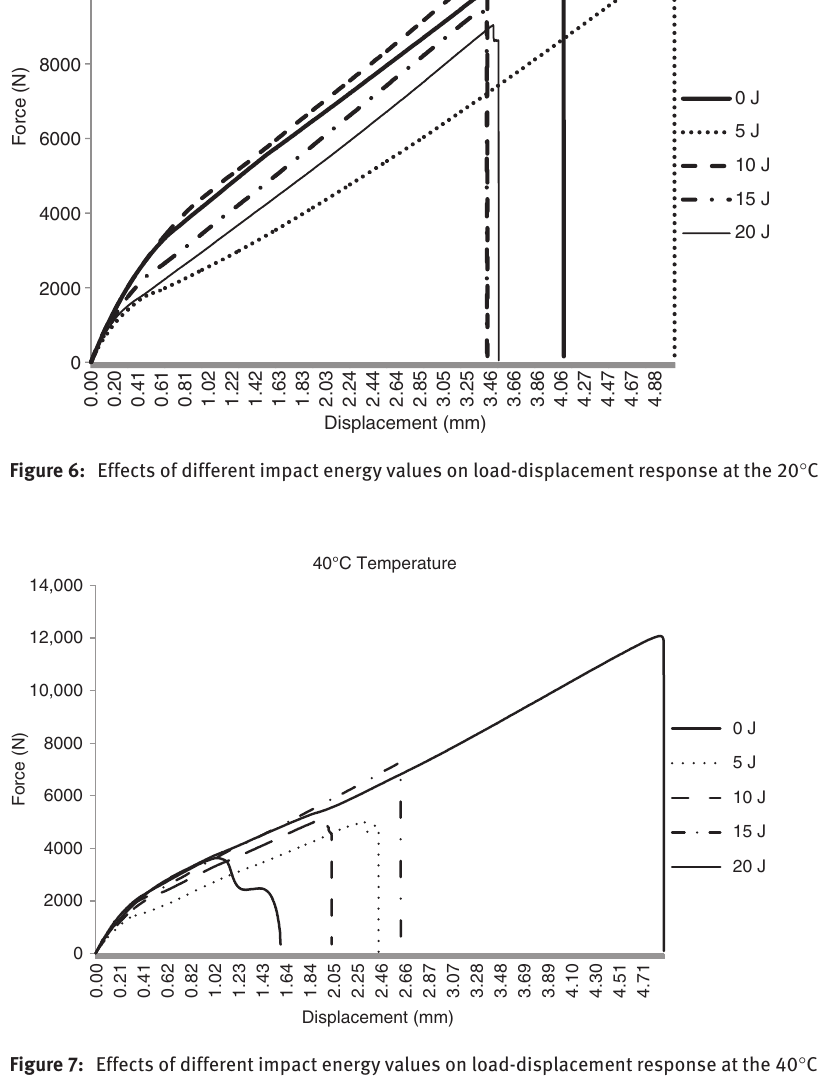
process temperature. Another prominent factor